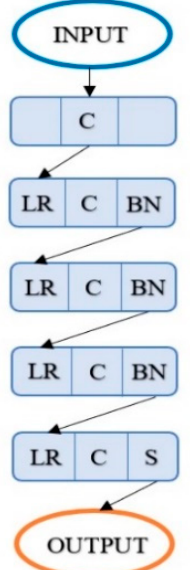
Figure 5. The architecture of the GAN discriminator. LR—leaky rectified linear unit, C—convolutional layer, BN—batch normalization, and S— sigmoid function.